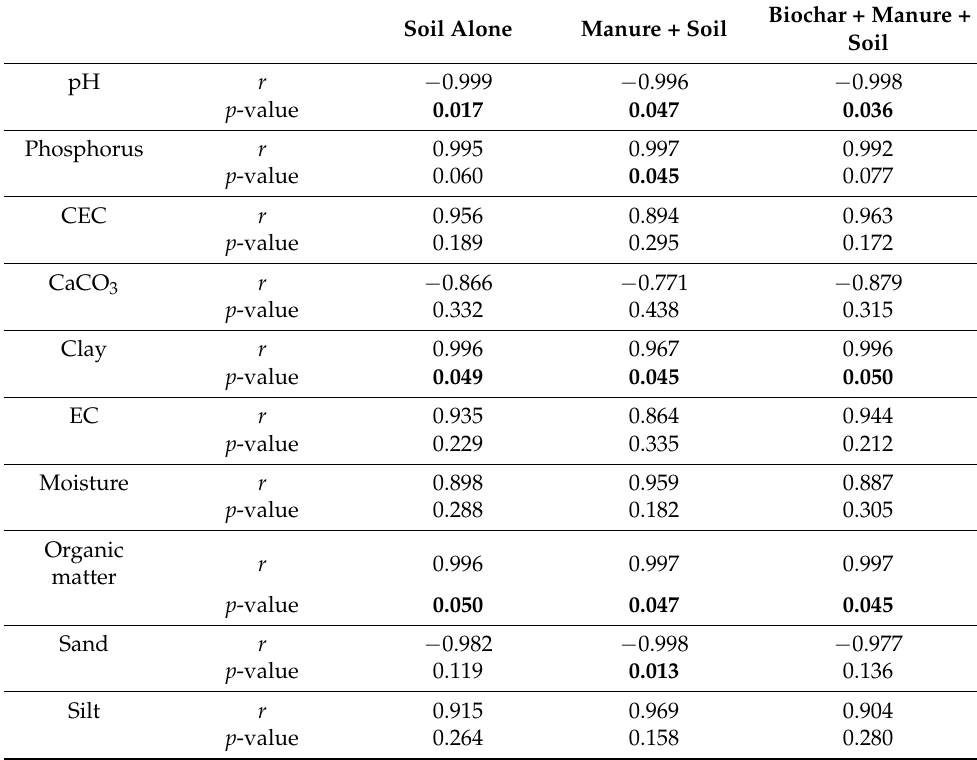
Table 3. Pearson correlations of various soil properties with doxycycline sorption onto soil alone, manure + soil, and biochar + manure + soil. Biochar + Manure Soil Alone Manure + Soil